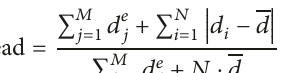
where 𝐷 𝑖 denotes the Euclidean distance between the i th non- dominated solution and the nearest nondominated solution on the real Pareto front and 𝑁 denotes the size of the Pareto optimal set. The smaller the GD, the closer the Pareto solution set to the real Pareto front and the better the convergence